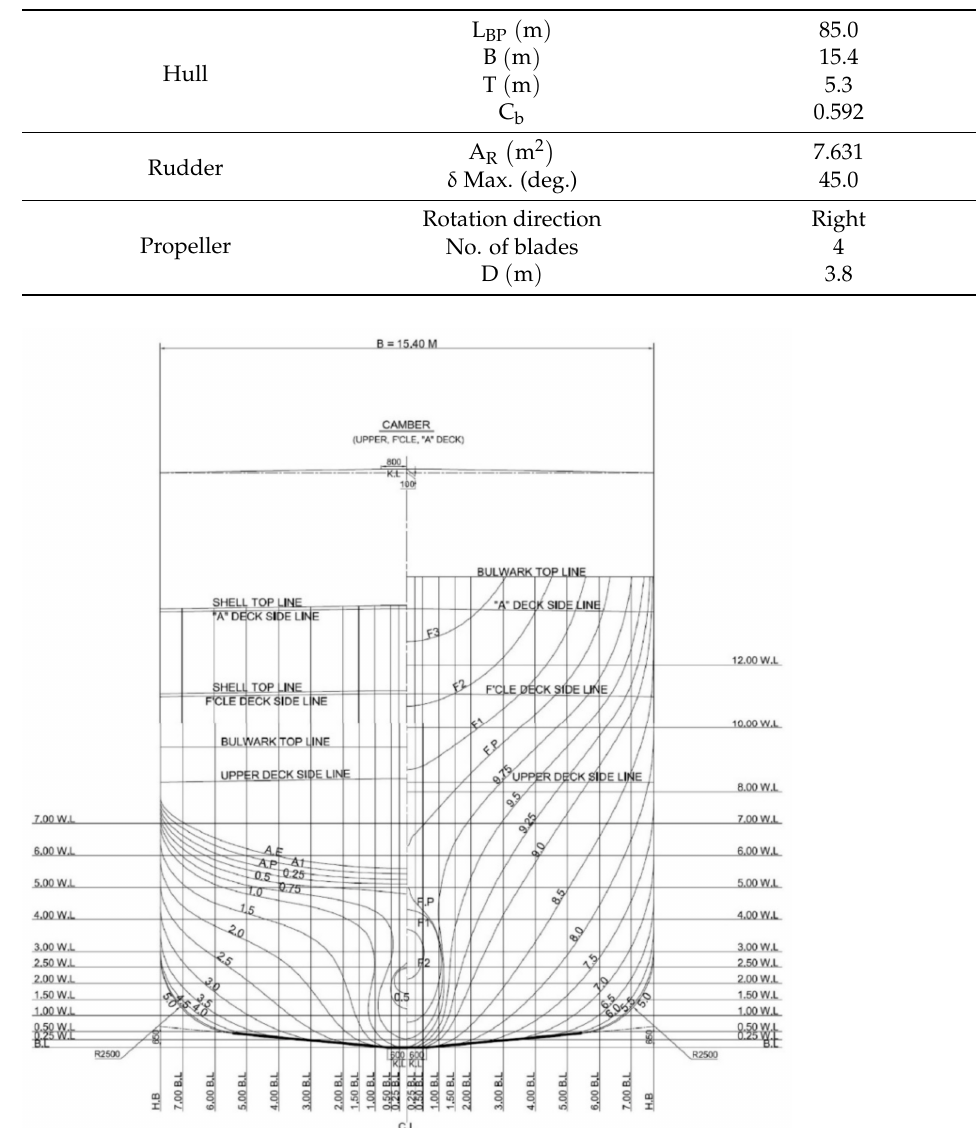
Table 4. Main specifications of Target fishing vessel.